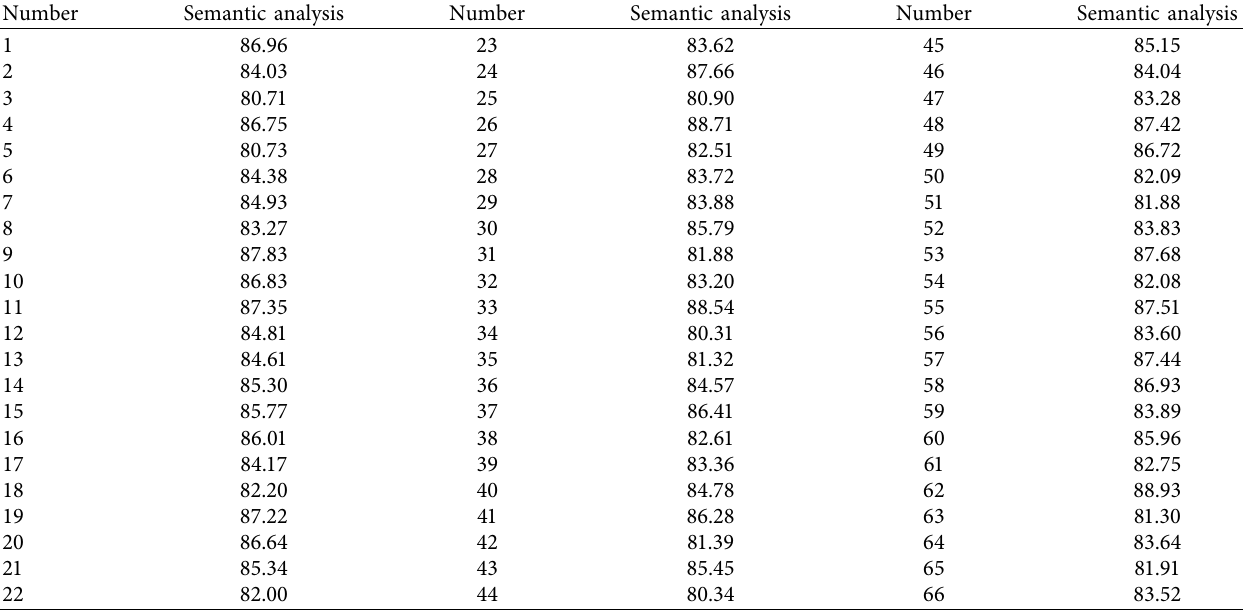
Table 1: Semantic analysis and evaluation of personalized recommendation system for online shopping products based on online fast learning through latent factor